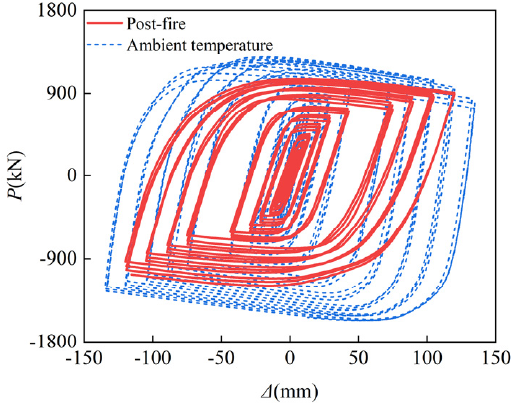
Figure 10. Hysteresis curves of P- Δ relations.